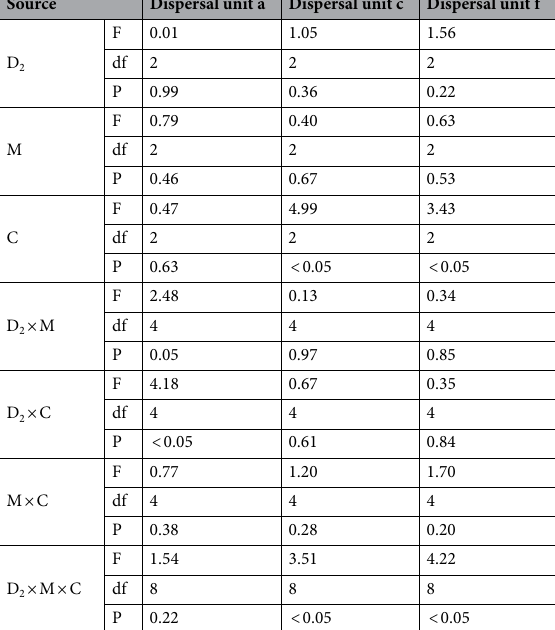
Table 2. Summary of three-way ANCOVAs showing effects of different levels of mixed density (D 2 ), plants from the three dispersal unit morphs (M), combination type of any two dispersal unit morphs (C) and their interactions on proportion of each dispersal unit morph from offspring of Certaocarpus arenarius . There was no significant effect of initial seedling size, which was used as a covariate, on any of the variables in the analyses (data not shown).